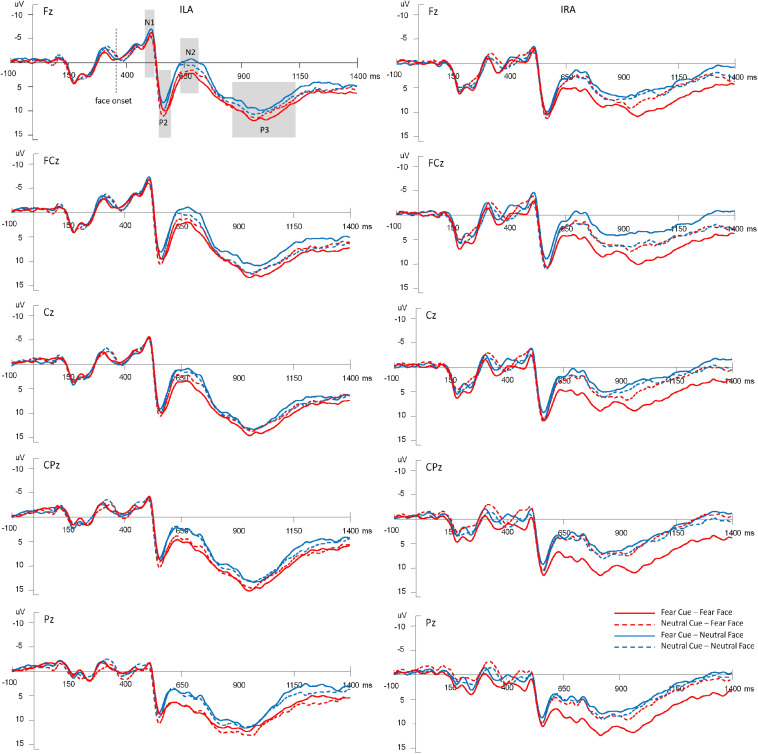
The average amplitudes of the four conditions at Fz, FCz, Cz, CPz, Pz electrodes for ILA and IRA, respectively.